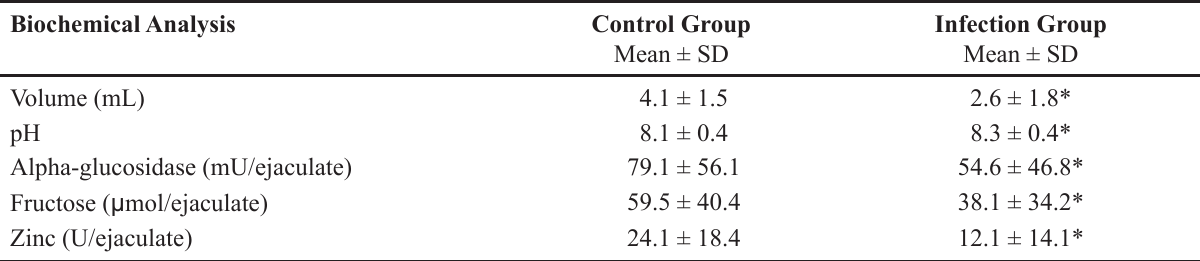
Table 3 – Comparison of the different secretory parameters of the male accessory glands between the controls and pa-